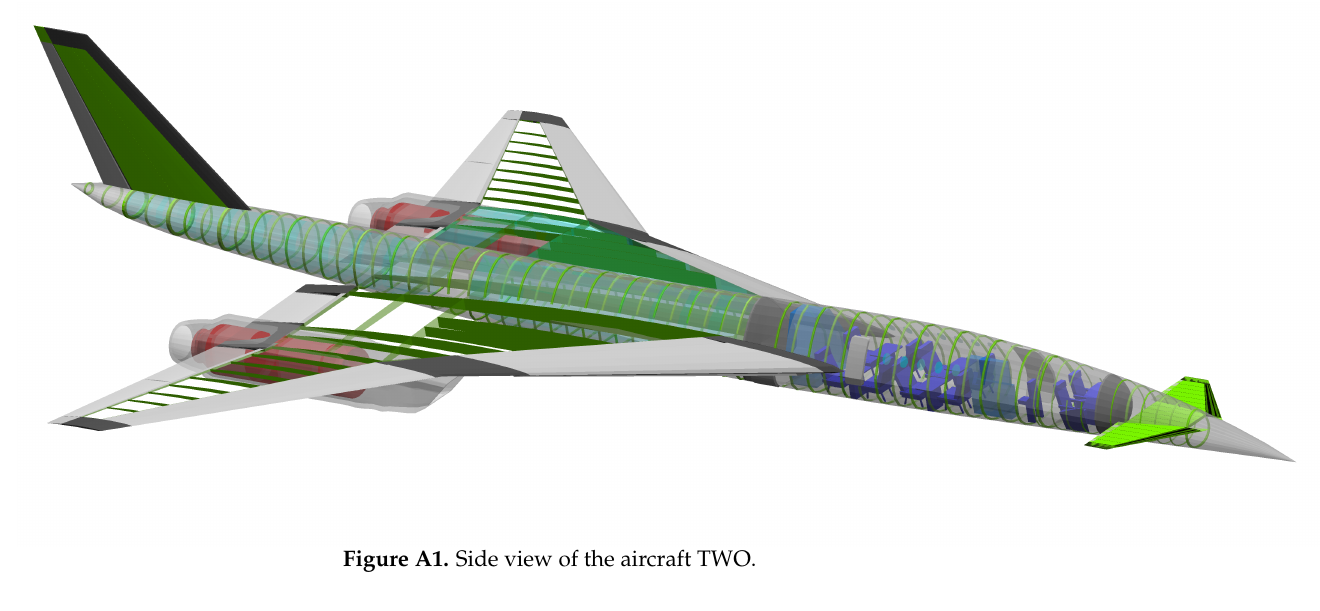
Figure A1. Side view of the aircraft TWO.